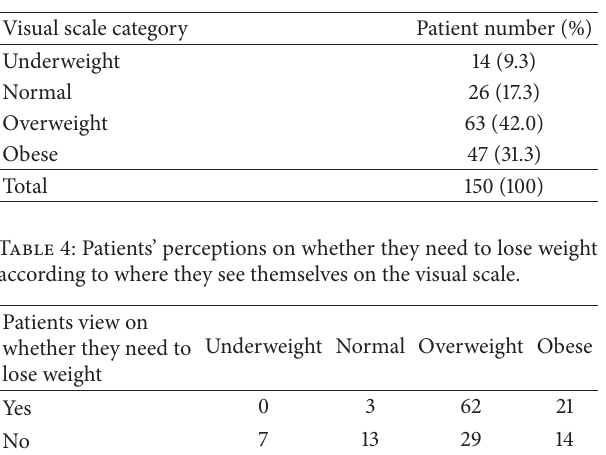
Table 3: Patients perceptions on which body image was normal for them.